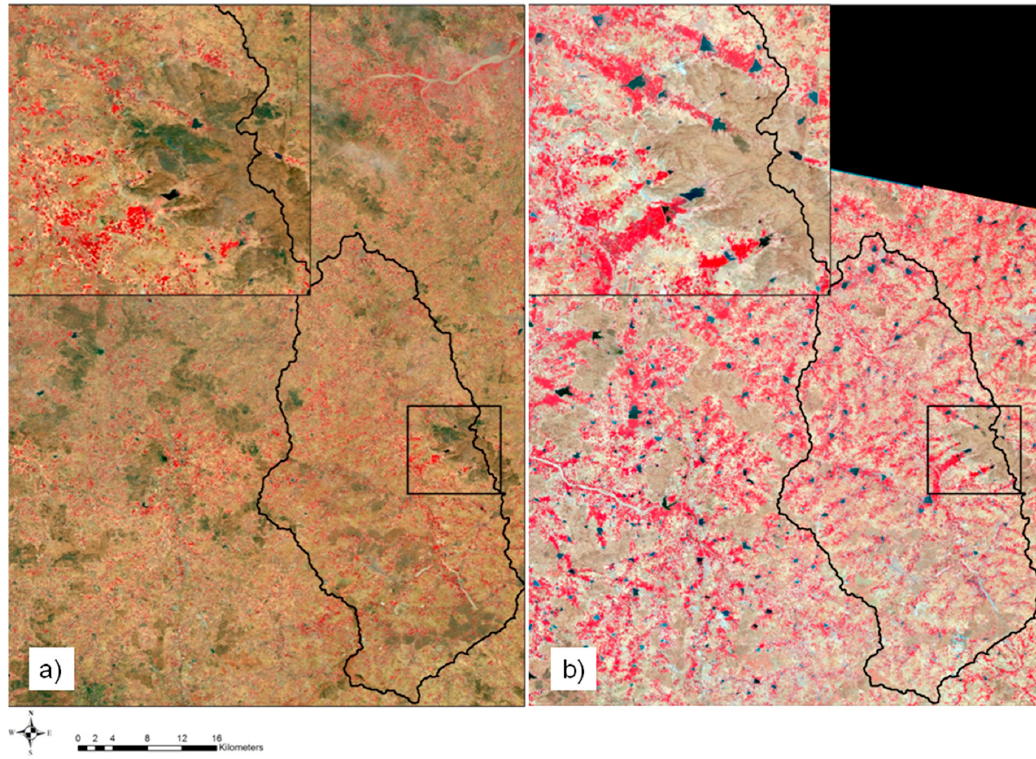
Figure 3. Sentinel-2 false color (infrared, red, and green color composite) ( a ) on 10 March 2016 (Rabi 2016) and ( b ) on 5 March 2017 (Rabi 2017). Red colors correspond to well-developed inundated rice, irrigated maize and vegetables. The black line represents the limits of the Kudaliar watershed. An enlarged view of the area located in the black square is shown at upper left. In Rabi 2017, small surface water areas (black) are visible, due to the water harvesting system’s refill during the exceptional high rainfall events of the previous 2016 monsoon (mainly September rainfall).